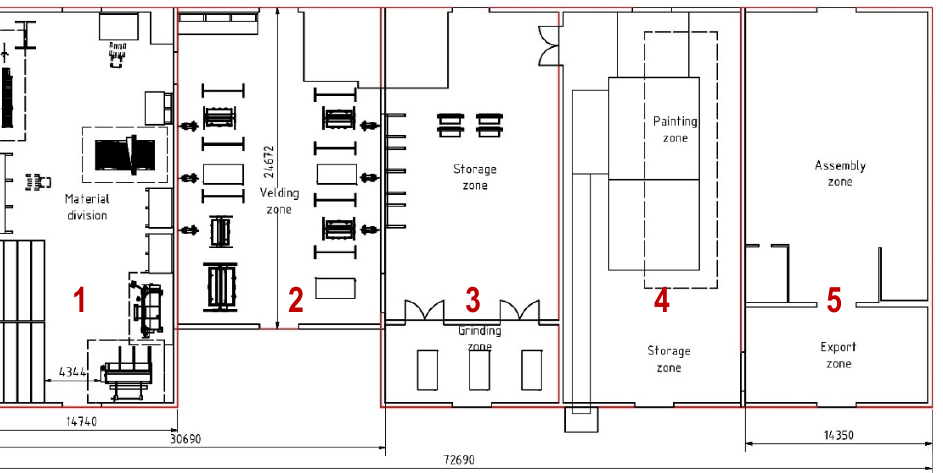
Figure 3. Design of layout of the production plant.